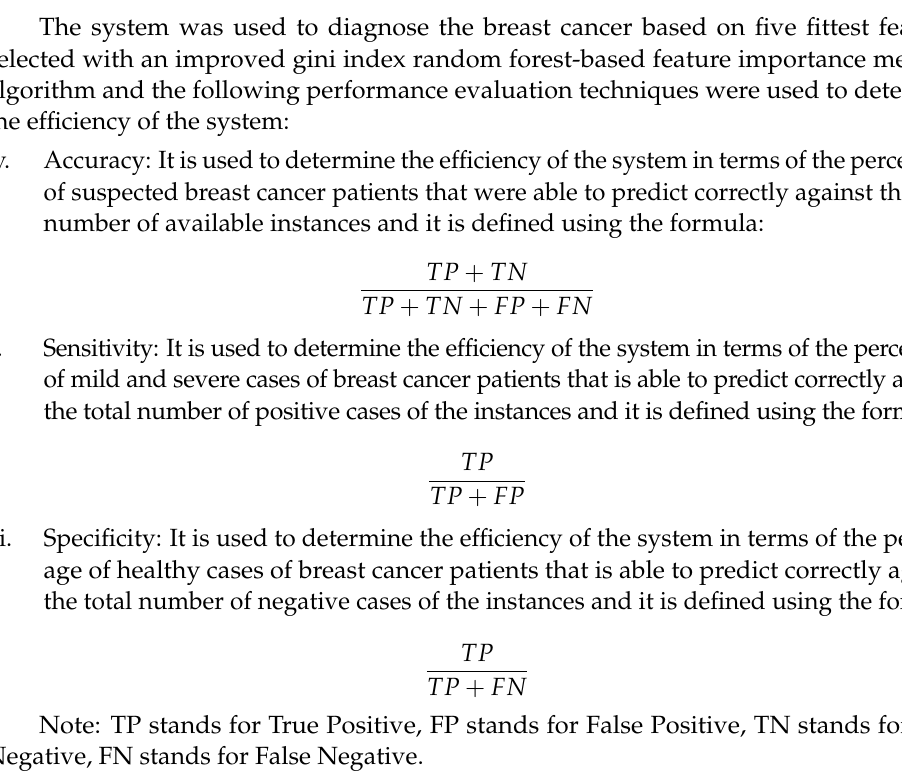
Figure 25. Diagnosis for healthy cases.